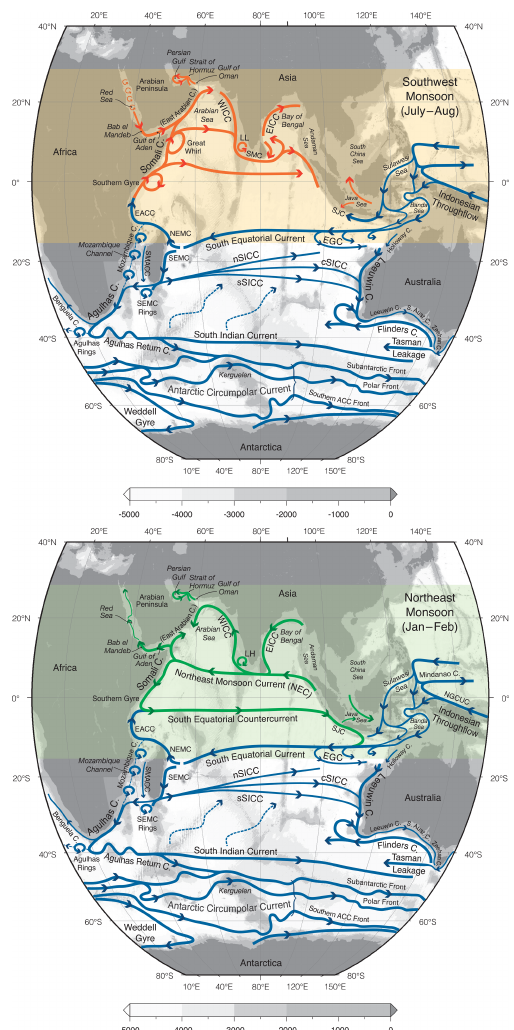
Figure 10. The top panel shows a schematic near-surface circula- tion during the southwest monsoon (July–August). Blue arrows in- dicate year-round mean flows with no seasonal reversals. Orange ar- rows indicate monsoonally reversing circulation (following Schott and McCreary, 2001). The Antarctic Circumpolar Current (ACC) fronts are taken directly from Orsi et al. (1995). Acronyms are as follows: EACC, East African Coastal Current; NEMC, North- east Madagascar Current; SEMC, Southeast Madagascar Current; SMACC, Southwest Madagascar Coastal Current; WICC, West In- dian Coastal Current; EICC, East Indian Coastal Current; LH and LL, Lakshwadeep high and low; SJC, South Java Current; EGC, Eastern Gyral Current; SICC, South Indian Countercurrent (south, central, and southern branches); NEC, Northeast Monsoon Cur- rent; SEC, Southwest Monsoon Current. Updated from Talley et al. (2011), originally based on Schott and McCreary (2001). The light grey shading shows seafloor bathymetry. The bottom panel shows a schematic near-surface circulation during the northeast monsoon (January–February) with the details being the same as the top